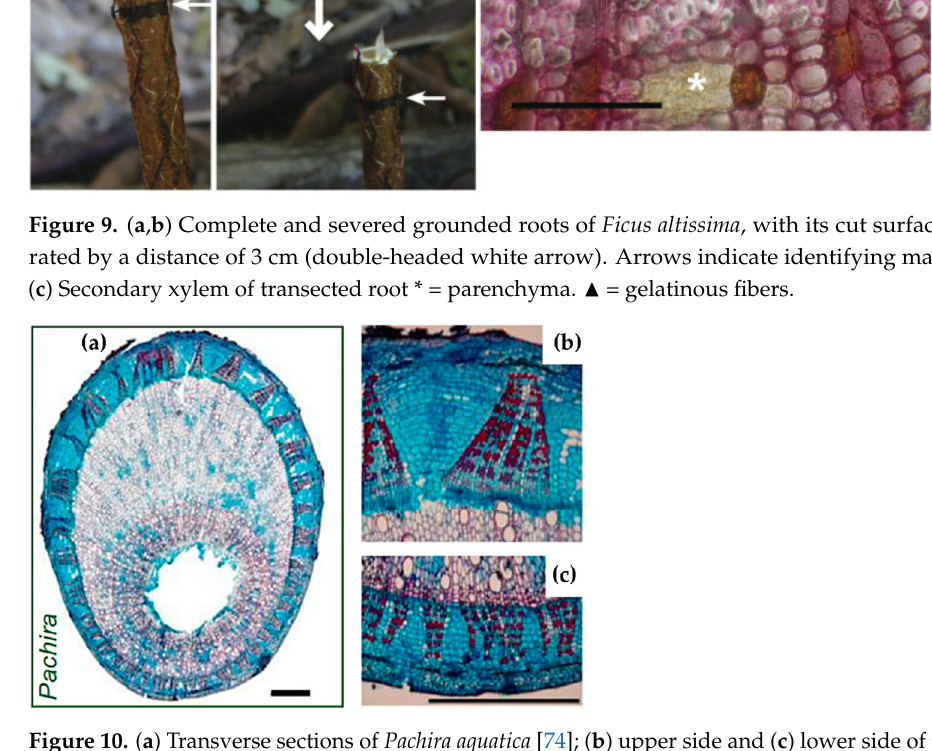
Figure 10. ( a ) Transverse sections of Pachira aquatica [74]; ( b ) upper side and ( c ) lower side of the tiled tree stem, including xylem and bark.